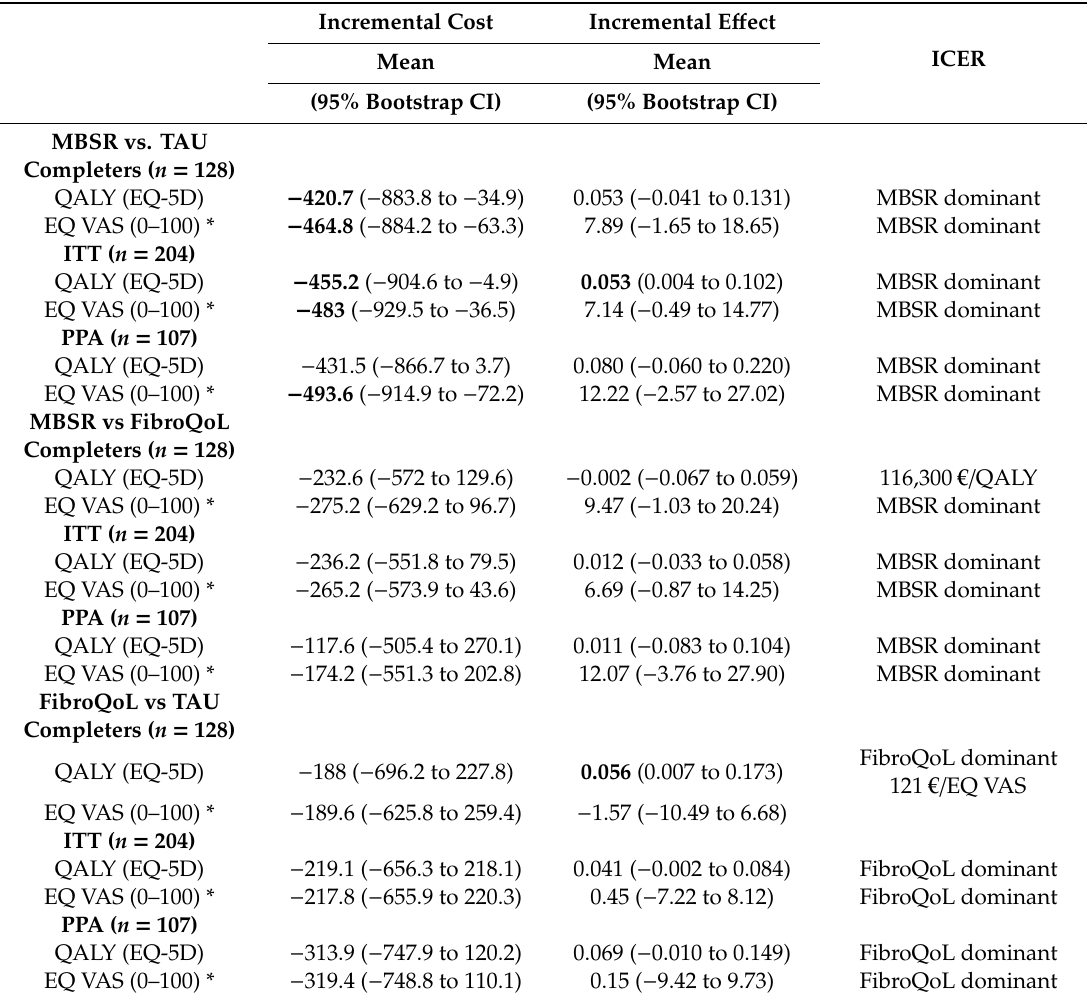
Table 5. Incremental cost, e ff ect, and cost-e ff ectiveness ratios from the health care